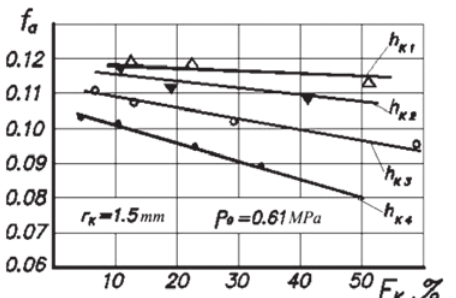
Fig. 8 . Dependence of the adhesion component of the friction factor f а on the relative area of micro grooves F K at different sample roughness R Z